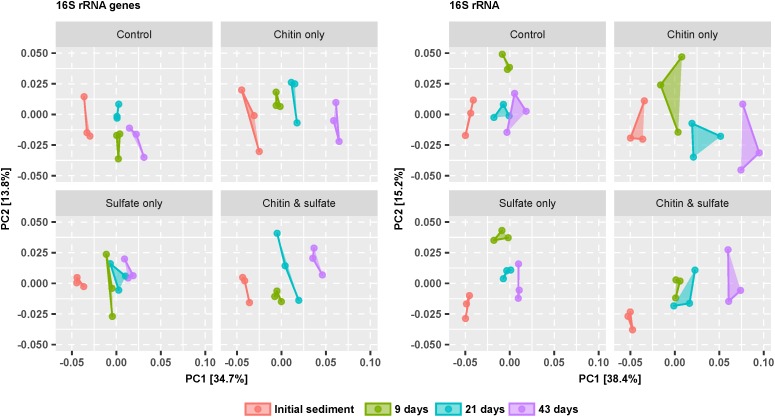
Time-resolved beta-diversity of bacterial communities in the various microcosm setups according to a principal coordinate analysis (PCoA) based on the weighted unifrac metric. Segregation of the bacterial community over time is shown for the 16S rRNA gene and 16S rRNA amplicon survey separately. Connected points of the same color represent biological replicates (n = 3).